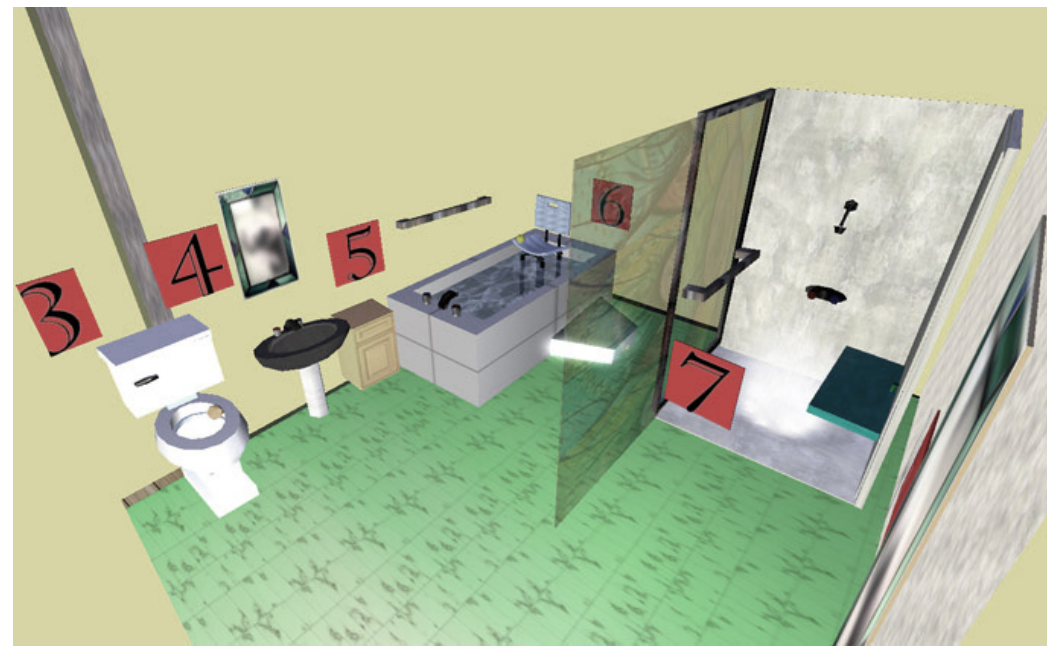
Figure 9 . Bathroom in Jefferson’s Adaptation